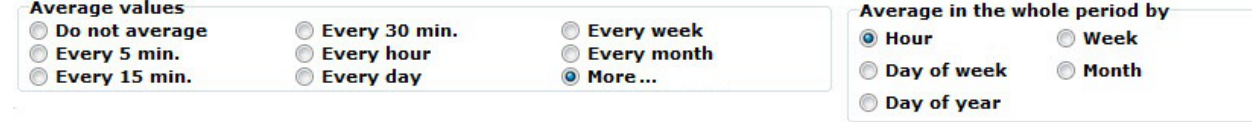
Figure 10. Additional options for averaging.